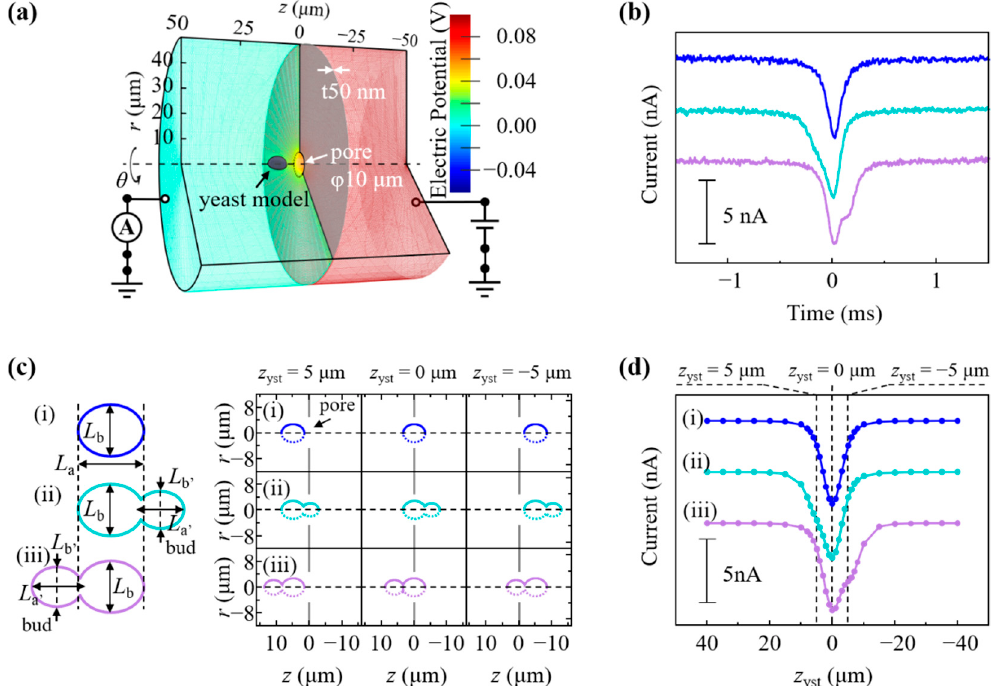
Figure 4. ( a ) Geometric structure modeled in a cylindrical coordinate system. r , θ , and z indicate coordinate, azimuthal angle, and axial coordinate, respectively. The color scale at the right represents the electric potential. ( b ) Measured symmetric waveform (blue), waveform with the shoulder before peak time (cyan), and waveform with a shoulder after peak time (purple). ( c ) Simulated model of passing through the pore of the nonbudding cell (i) and budding cell with daughter in front of (ii) or behind (iii) mother cell. ( d ) Simulated waveforms of the nonbudding cell (i), budding cell with daughter in front of (ii) or behind (iii) mother cell.